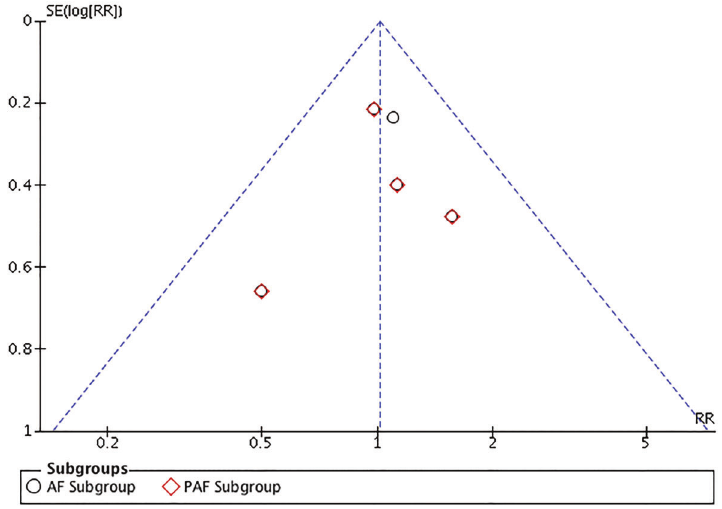
CF group. On the other hand, there was no difference in fl uoroscopic duration between the CB and CF groups (MD=0.59; 95%CI= – 4.48 – 5.66; P=0.82). Nevertheless,